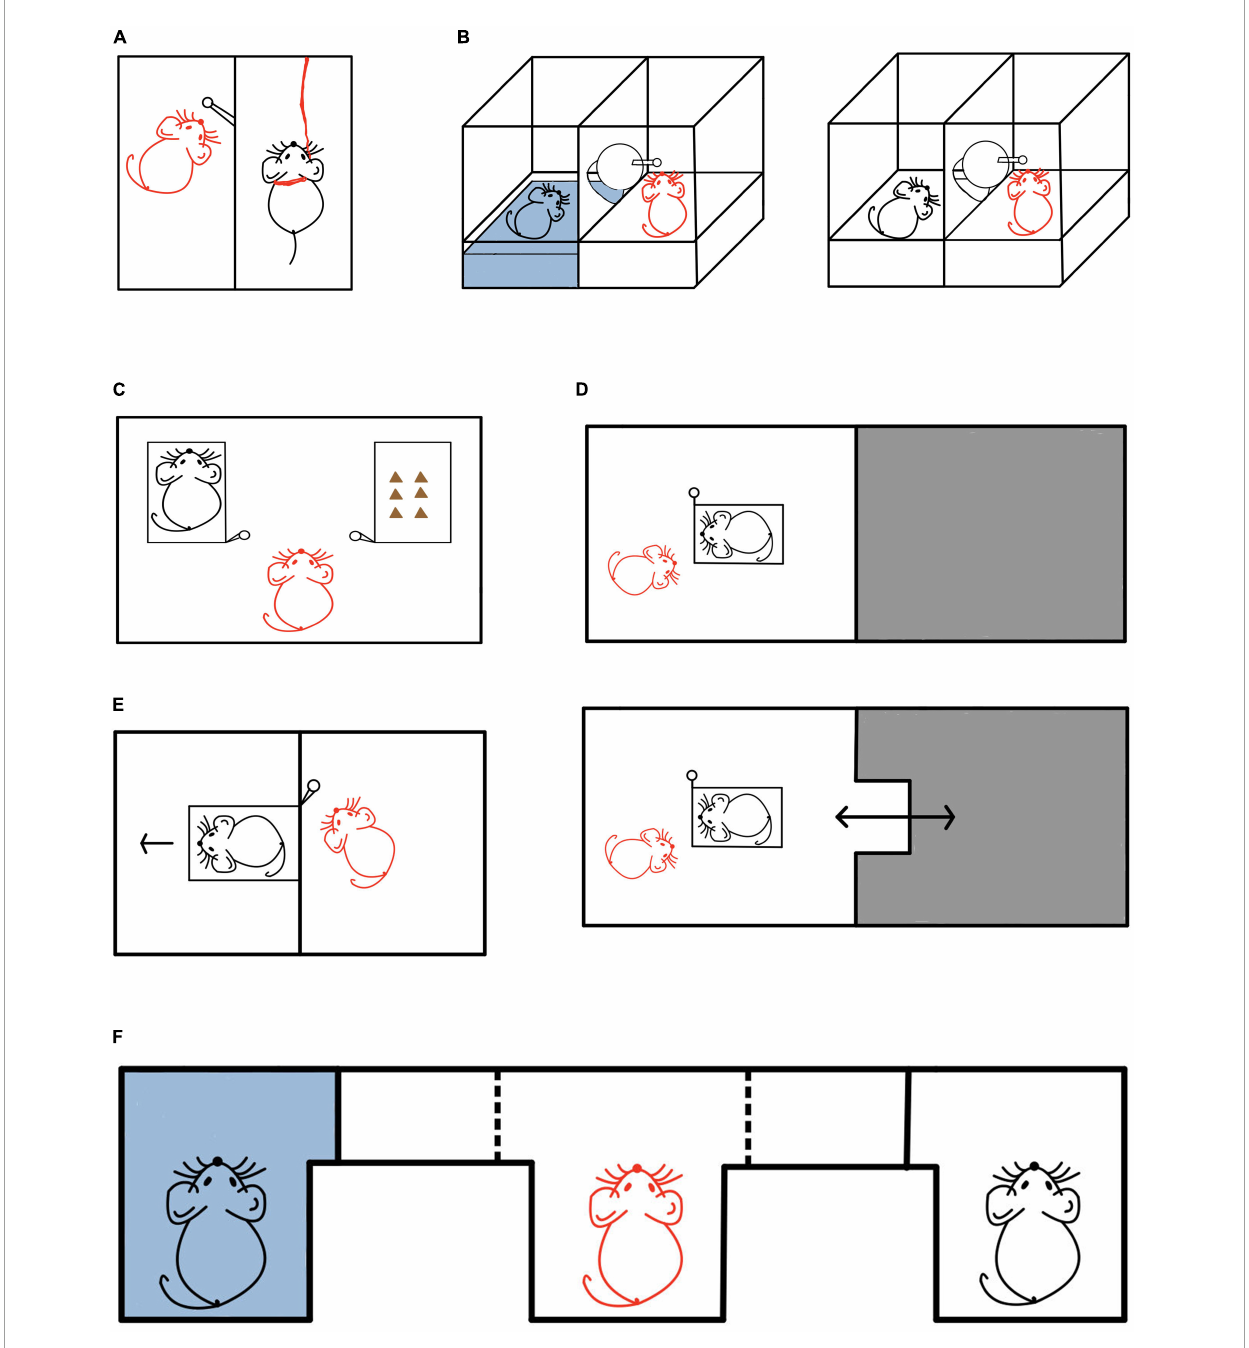
FIGURE1 Helping behavior experiments in rodents. (A) In this experiment, a black rat was in distress and a red rat was the free rat (helper). The free rat had the ability to press the lever bar to rescue the distressed rat, who was suspended in the air by a harness (Rice and Gainer, 1962). (B) In this experiment, a black rat was either in distress or not, and a red rat was the free rat (helper). When the distressed rat was trapped in the water (left panel), the free rat could learn to rescue the trapped distressed rat by pulling the lever. As sessions progressed, the latency to help decreased. In contrast, the free rat did not pull the lever when the rat was not in distress in the ground area (right panel) (Sato et al., 2015). (C) In this experiment, a black rat was trapped in the left restrainer and in need of help, with some chocolate in the right restrainer. The red rat was the free rat (helper). When faced with the choice of rescuing the conspecific and enjoying the delicious food, the free rat chose to first rescue the trapped conspecific and share the food with it (Bartal et al., 2011). (D) In this experiment, a black rat was trapped in the restrainer and in need of help, and the red rat was the free rat (helper). The gray area was the darkroom that allowed the free rat to escape from the helping situation. In the upper panel, the darkroom door is closed, and the free rat cannot enter. But in the lower panel, the darkroom door is open, and the free rat can enter. Compared with rats in the non-escapable group (upper panel), rats in the escapable group (lower panel) had a longer delay in opening the door to help rescue the trapped rat (Carvalheiro et al., 2019). (E) In this experiment, a black rat was trapped in the restrainer and in need of help, and the red rat was the free rat (helper). Even when unable to make social contact after helping, the free rat still chose to open the door for the trapped rat in the restrainer (Bartal et al., 2011). (F) In this experiment, the black rats in need of help were placed at both ends of the E maze (left end: the rat was trapped in the wet goal box; right end: the rat was trapped in the dry goal box). The red rat in the middle was the free rat (helper) and could choose freely. It was found that the free rat preferred to interact with the rat in the wet goal box (Schwartz et al.,